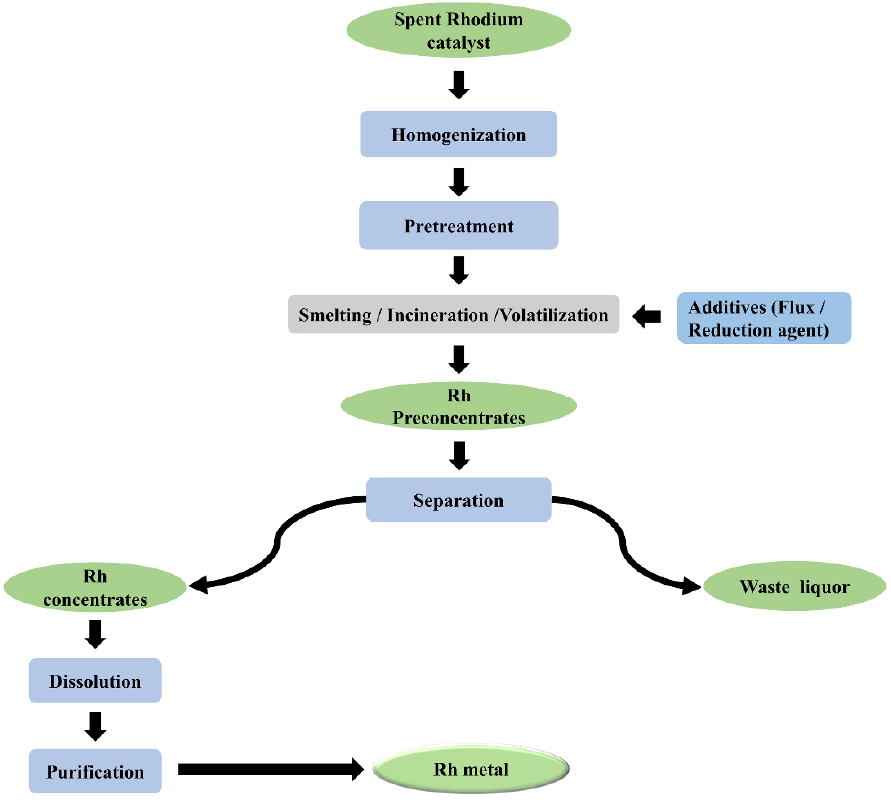
Figure 3. Flowsheet illustrating Rh recovery by the pyrometallurgical process.